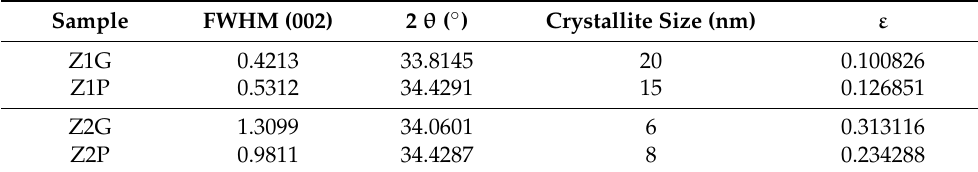
Table 2. Summary of structural parameters of ZnO thin films deposited on glass and mPS substrates by sol–gel spin coating and USP